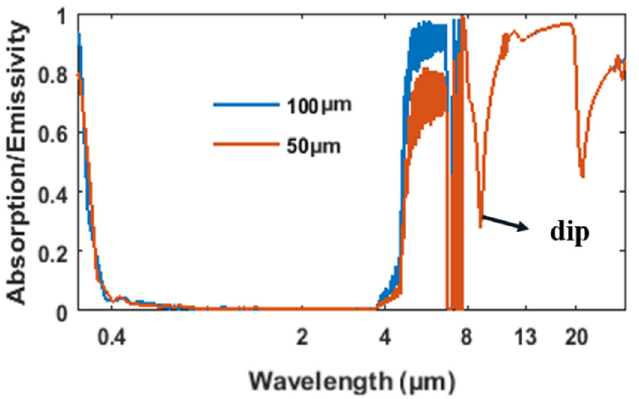
Figure 2. Absorption/emissivity of pure silica films with different thicknesses placed over a sliver substrate, calculated using the transfer matrix method [30].